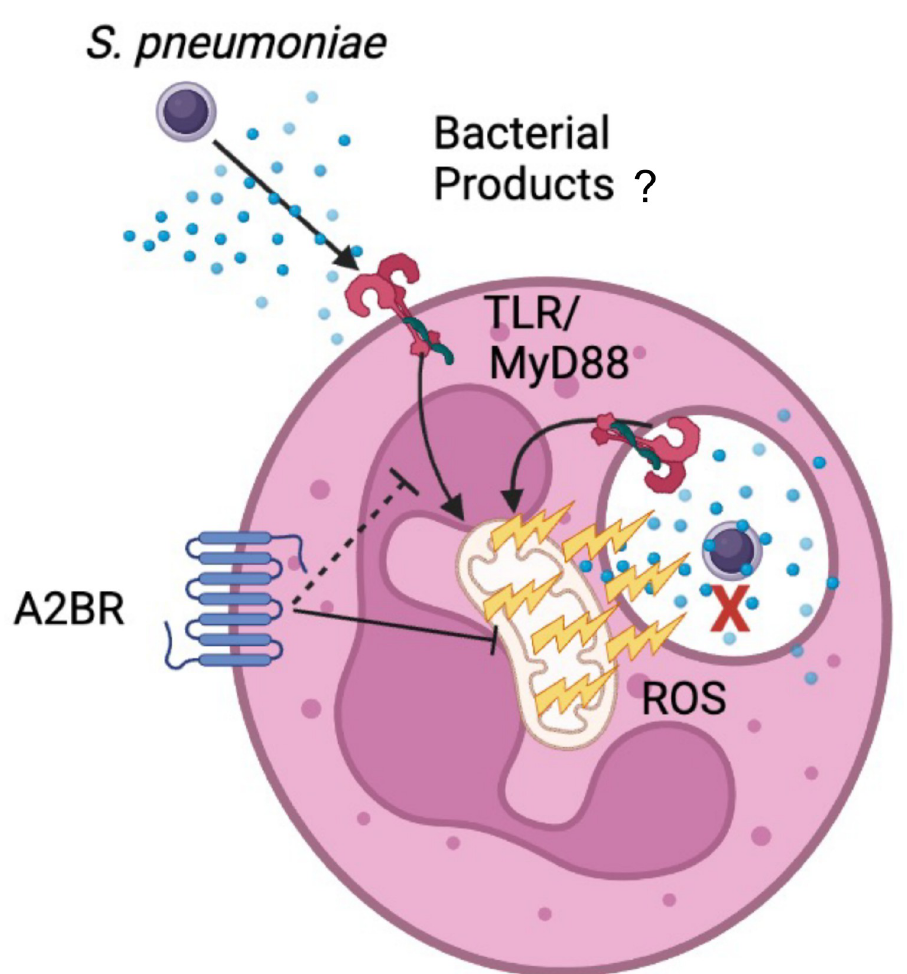
Fig 12. Model figure. S . pneumoniae induces mitochondrial ROS production by PMNs in a manner partially dependent on MyD88. This response is regulated by A2B receptor signaling and is required for the antimicrobial activity of PMNs. Images were created with